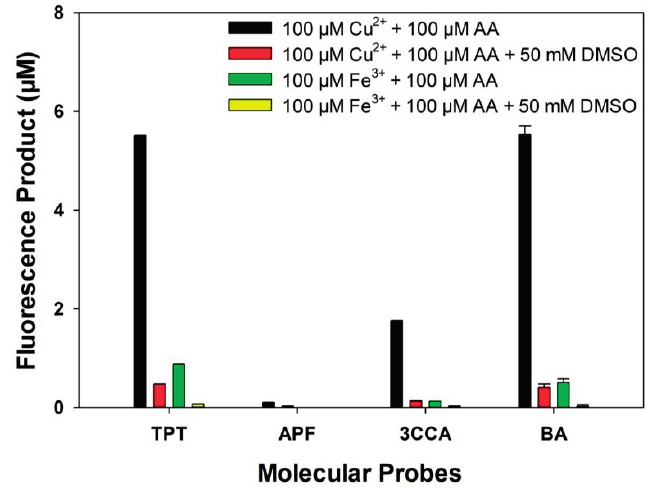
Figure 2. Concentrations of fluorescent products measuring •OH formation induced by Cu 2+ and Fe 3+ , in PBS with 100 μ M ascorbic acid, incubated at 37 °C for 2 h avoiding